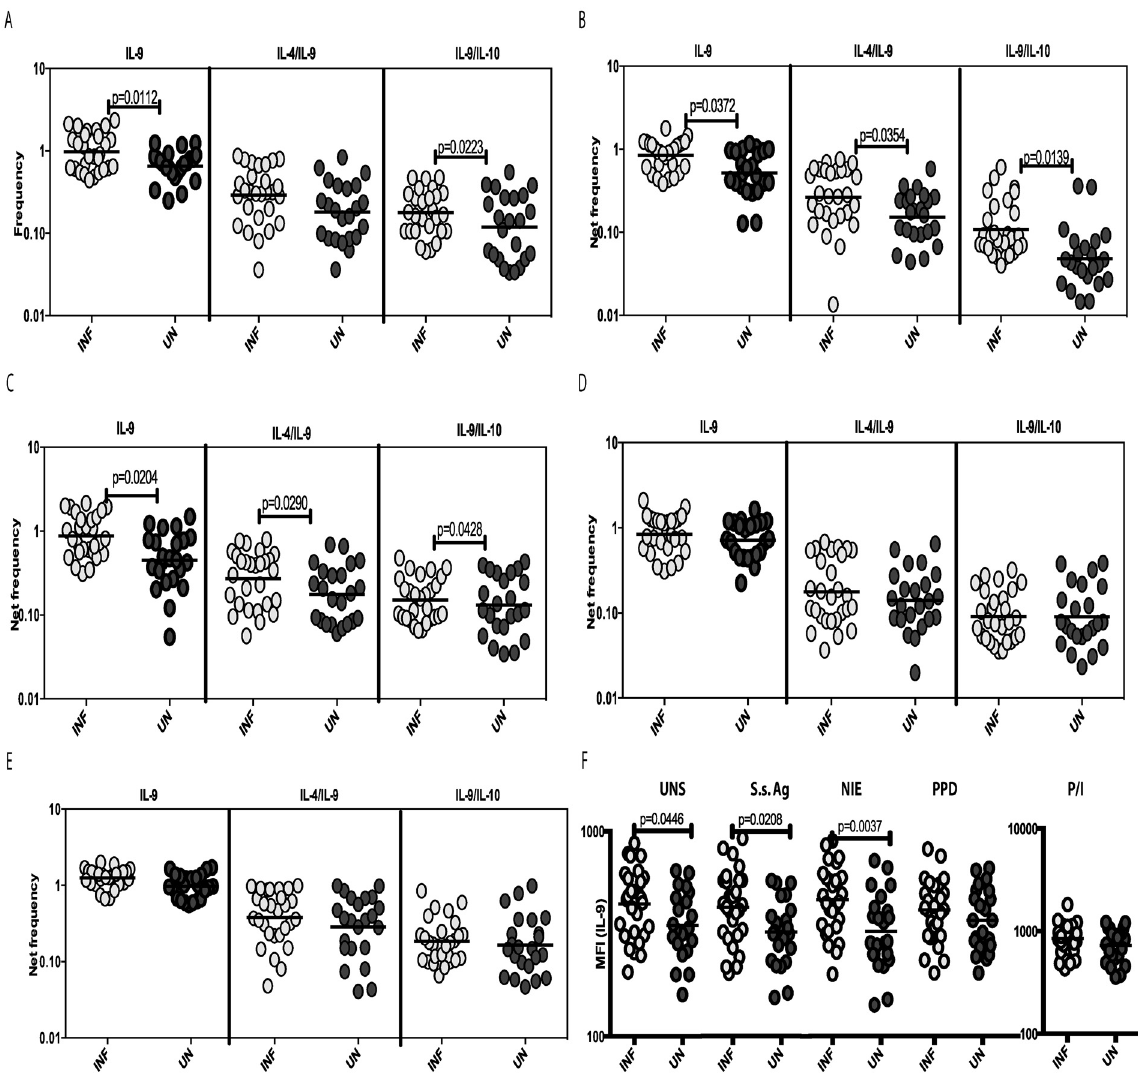
Fig 2. Strongyloides infection is associated with increased spontaneously expressed and antigen-induced frequencies of CD4 + mono- and dual- functional Th9 cells. Whole blood was cultured with media alone or with antigens for 6 h and the baseline and antigen-stimulated frequencies of Th9 cells determined. The baseline (A) as well as SsAg (B), NIE (C), PPD (D) and P/I (E) stimulated frequencies of mono- and dual-functional CD4 + Th9 cells in INF (n = 28) and UN (n = 23) individuals are shown. The MFI of IL-9 expression on CD4 + T cells in INF and UN individuals at baseline and following stimulation are shown (F). Each circle represents a single individual and the bars represent the geometric mean values. Net frequencies were calculated by subtracting baseline frequencies from the antigen-induced frequencies for each individual. P values were calculated using the Mann-Whitney